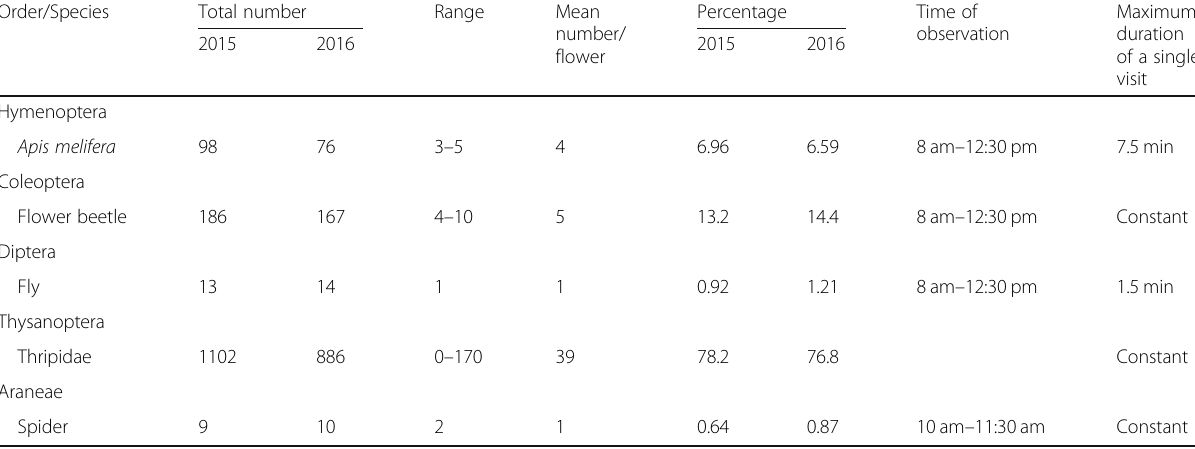
Table 2 Number of insects per order visiting Magnolia grandiflora flowers (2015 –